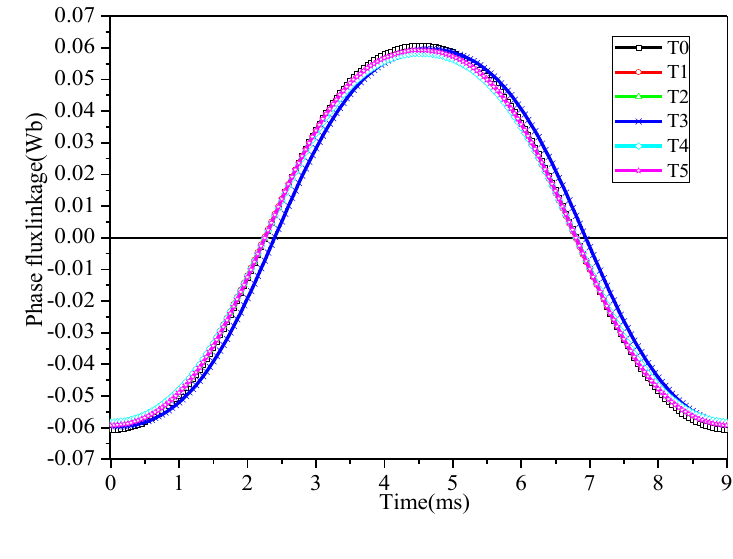
Figure 17. Profiles of flux linkage of Phase A in one electrical